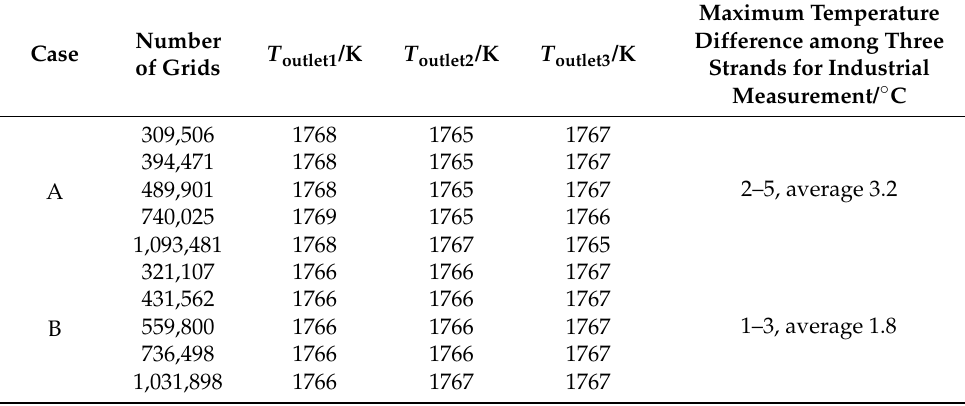
Table 7. Mesh independence study and model